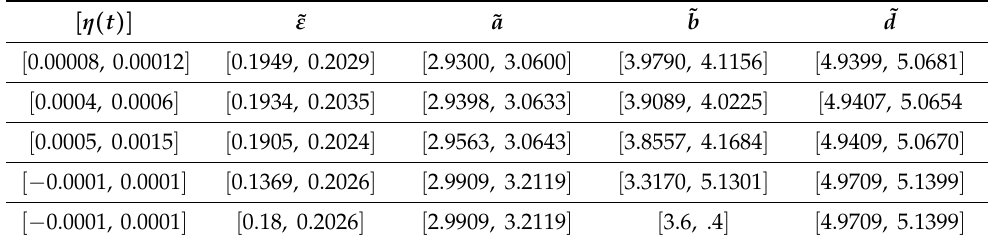
Table 1. Parameter values obtained with the method presented in Section